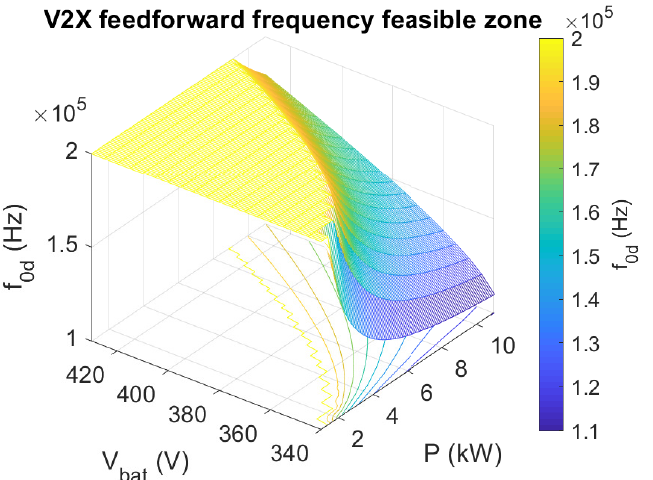
Figure 6. Feedforward frequency in V2X mode with respect to battery voltage and power